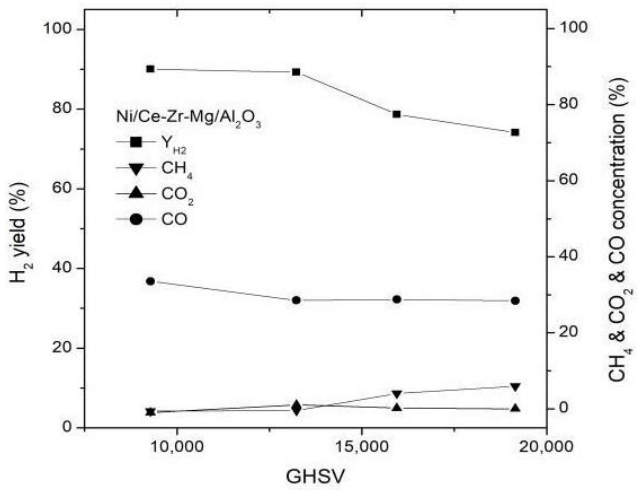
Figure 8. Effect of GHSV on H 2 yield and CH 4 concentration during the waste plastic pyrolysis oil reforming reaction.(temp.=850 °C , S/C = 2 ).